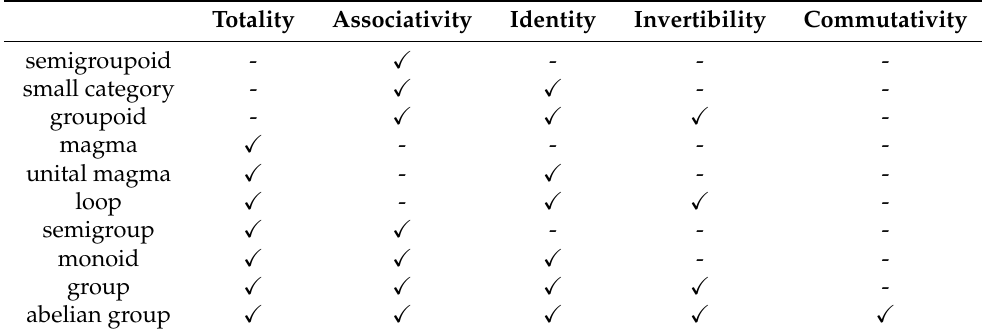
Table 1. Various algebraic structure and their properties [29].